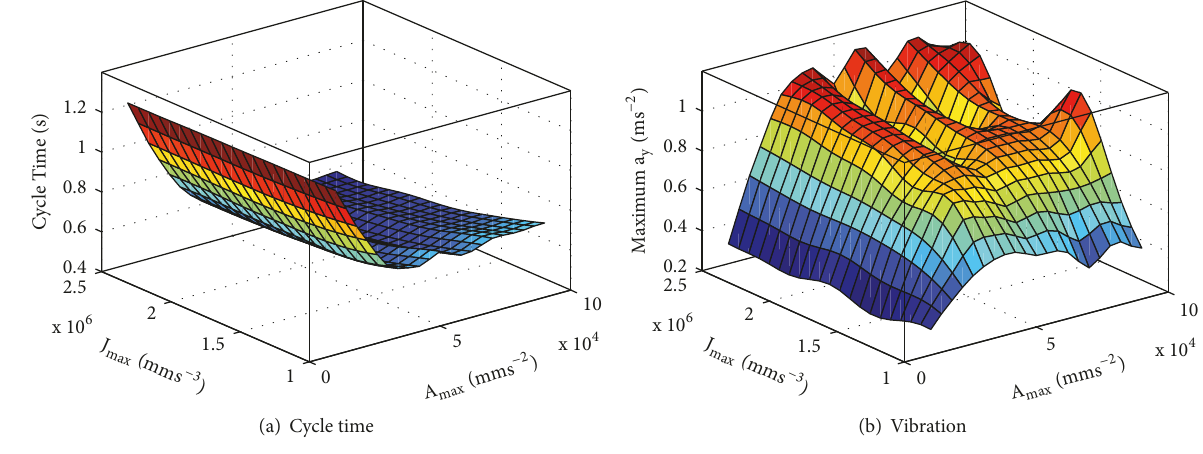
Figure 13: Slice of the generated